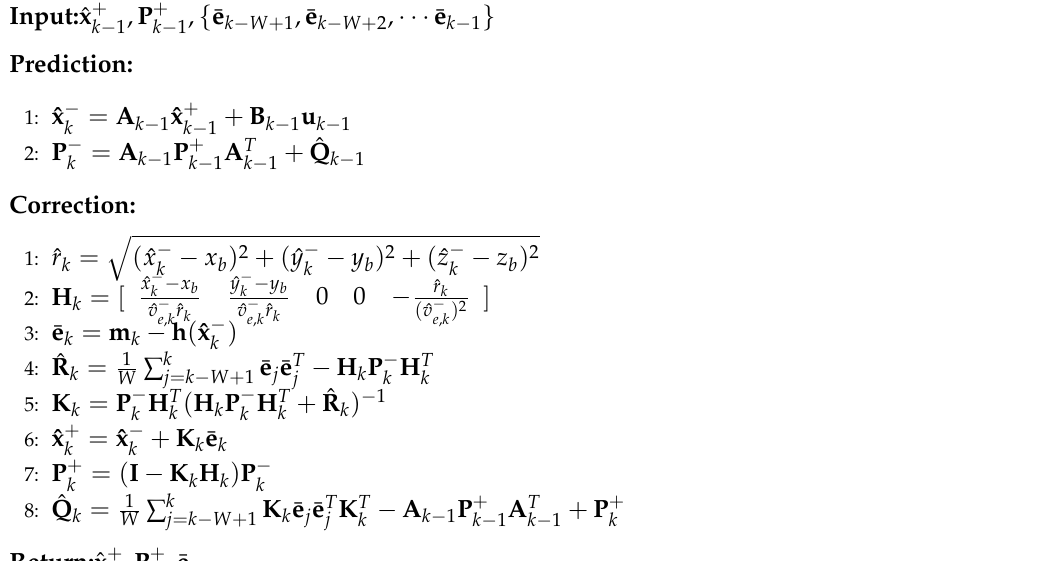
Algorithm 1 Windows-based adaptive single-beacon underwater tracking